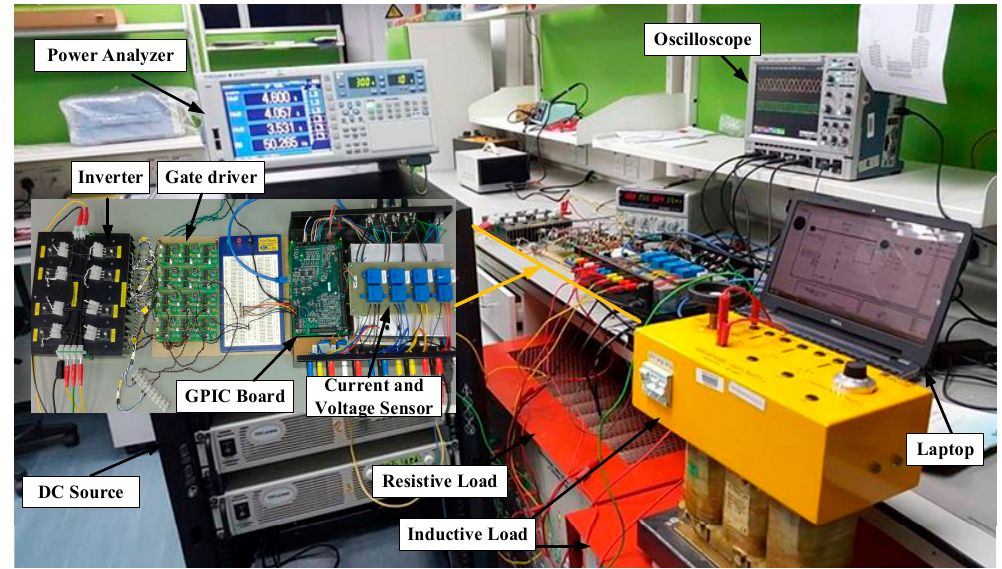
Figure 4. Experimental setup in the FPGA platform.